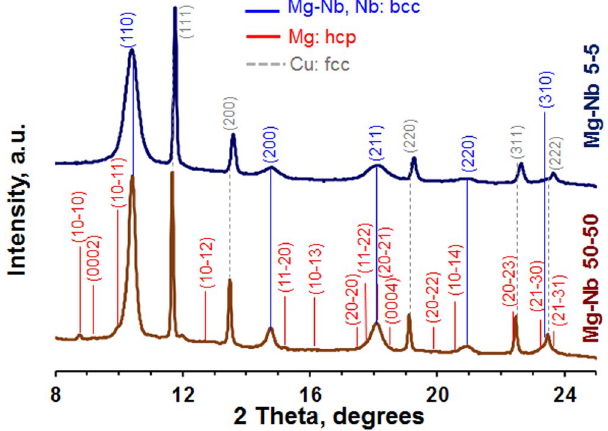
Figure 2. XRD of the 5 nm/5 nm bcc/bcc and the 50 nm/50 nm hcp/bcc Mg/Nb nanocomposite. Copper was used as a pressure marker during these